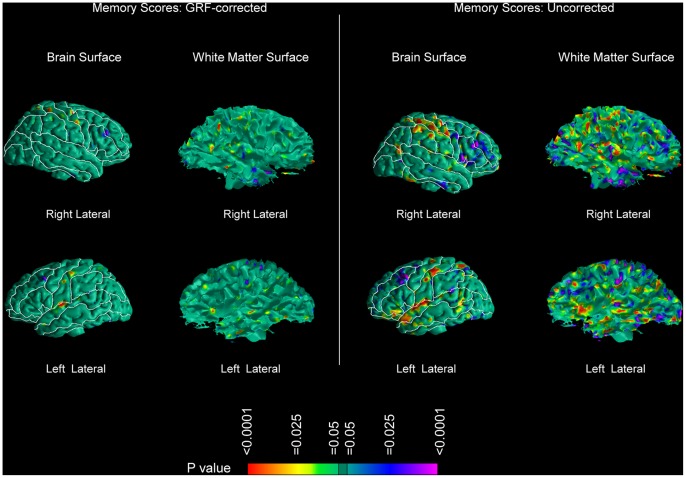
Correlations of Memory Scores with Local Volumes along the Surface of the Brain and of the Underlying WM.Statistical effects are color-encoded as in Fig. 1. (Left Half of the Figure) GRF-corrected results for the Brain Surface (Left Column) and for the WM Surface (Right Column). (Right Half of the Figure) Uncorrected results for the Brain Surface (Left Column) and for the WM Surface (Right Column). These figures demonstrate that increasing memory scores are associated with relatively greater local volumes along the WM surface. These correlations are within-group and they suggest that patients with better memory scores have a smaller degree of WM deficits. However, patients as a whole still have reductions in WM when compared with healthy controls, as shown in Fig. 1. Therefore the greater local volumes shown in this figure are not to be interpreted in the sense of an actual increase of WM in the patient group.